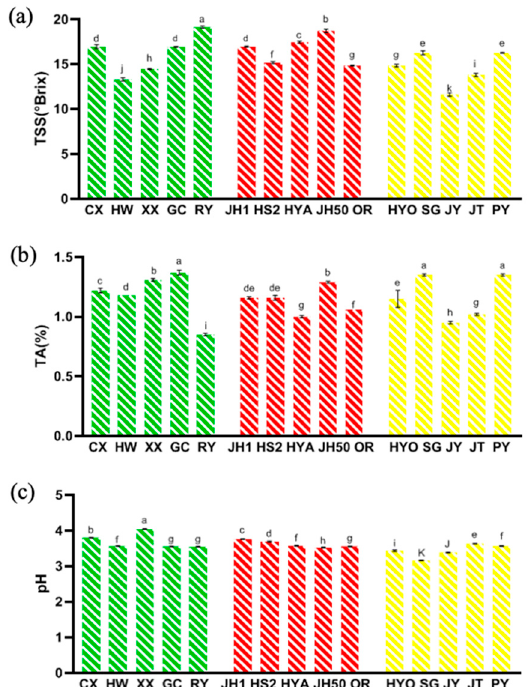
Figure 2. Three physicochemical characteristics in 15 kiwifruit cultivars. ( a ) Total soluble solid (TSS); ( b ) Titratable acid (TA); ( c ) pH (mean ± SD; n = 3). Mean values in each column with unlike letters are significantly different among cultivars ( p < 0.05).